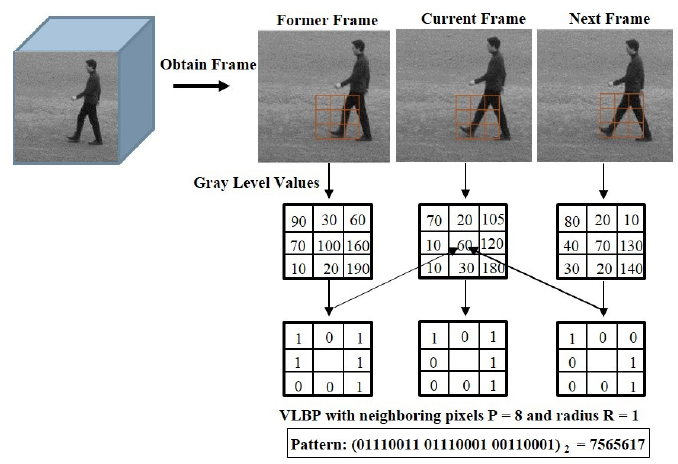
Figure 3. An approach of computing Volume Local Binary Pattern (VLBP) on three successive frames.